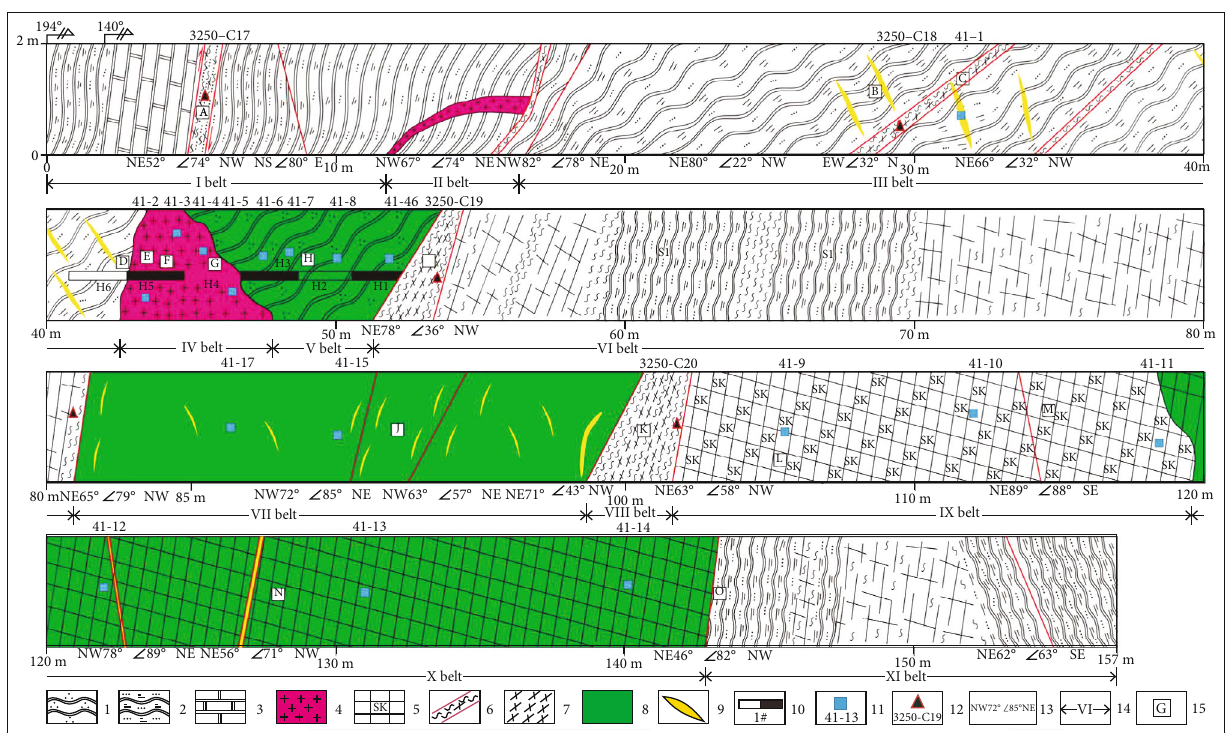
Figure 5: Sketch map of Stope 41 in the tunnel 3,250m section, Yangla copper deposit, Yunnan, China. 1: quartzite; 2: sericitic sandy slate; 3: marble; 4: granite porphyry; 5: skarn; 6: fracture zone; 7: tectonic cataclastic rocks; 8: copper ore body; 9: quartz-calcite vein; 10: base samples and corresponding numbers; 11: specimen and corresponding numbers; 12: tectonic geochemical samples and corresponding numbers; 13: fracture occurrence; 14: mineralization – lithologic alteration zones and corresponding numbers; and 15: locations and corresponding numbers of photographs (Figure 6). Zone I: weak chloritization – pyritization – silici fi cation; Zone II: fi ne-veined calcitized – pyritized granite porphyry; Zone III: strong silici fi cation – calcitization – weak pyritization; Zone IV: granite porphyry vein with strong silici fi cation and calcitization, pyritization, chalcopyritization, and molybdenitization; Zone V: skarn-type copper ore body; Zone VI: fracture crushing zone; Zone VII: massive ore-rich body; Zone VIII: fracture crushing zone; Zone IX: yellowish-brown – brown massive garnet skarn; Zone X: massive skarn-type ore body; and Zone XI: weakly skarni fi ed sericitic sandy slate and metamorphic quartz